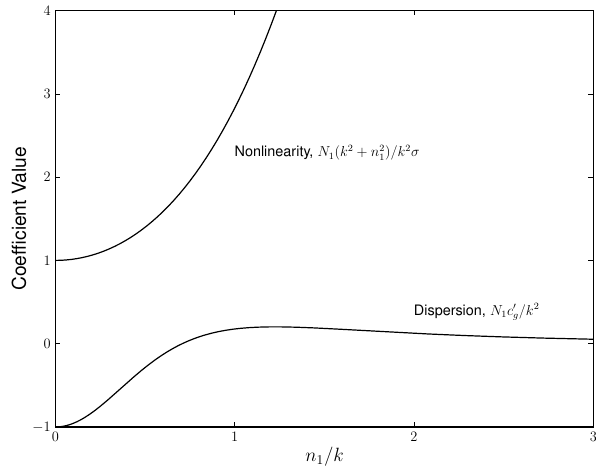
Figure 2. Behavior of the coefficients of the dispersion and nonlin- ear terms in the amplitude equations as n 1 /k